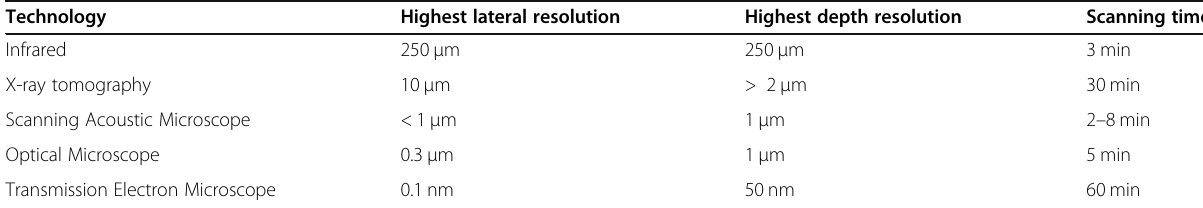
Table 1 Imaging methodology for interface analysis a Technology Highest lateral